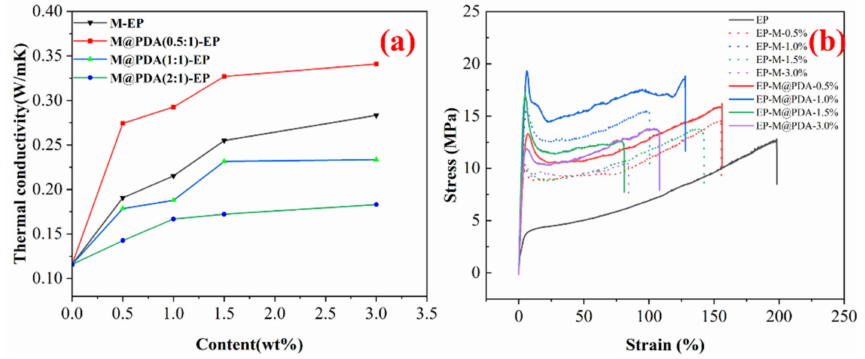
Figure 4. ( a ) Thermal conductivity of MWCNTs@PDA epoxy composites. ( b ) Typical stress–strain curves of MWCNTs epoxy composites and MWCNTs@PDA epoxy